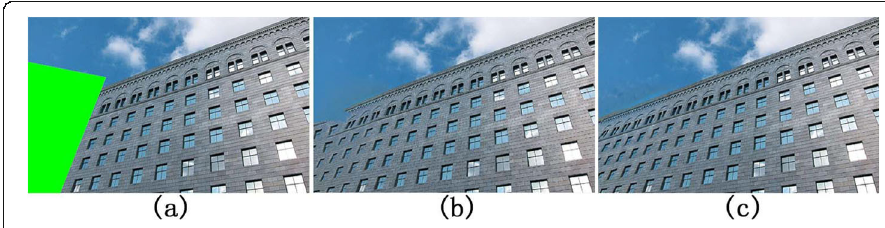
Fig. 11 Effect of guidance map. a Input. b Our result (unguided). c Our result (guided)